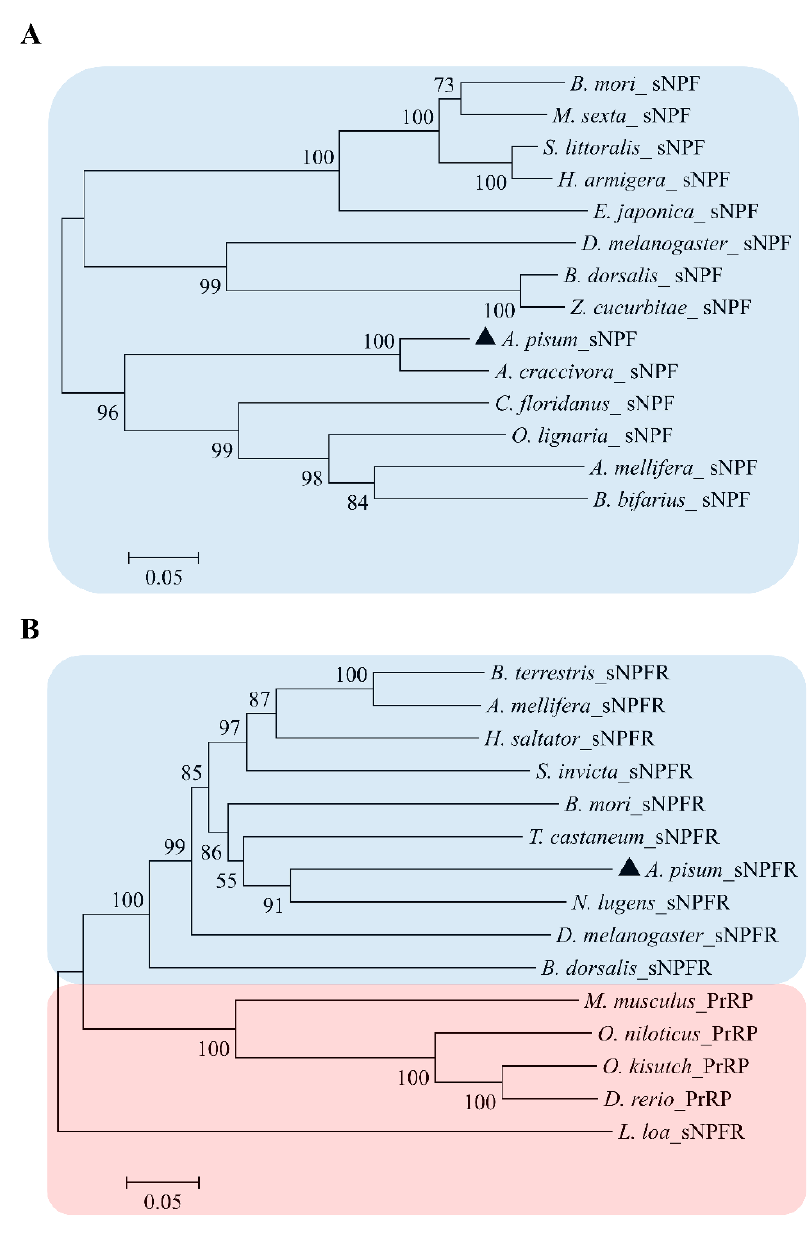
Figure 3. Phylogenetic relationship of sNPF precursors with other insect species ( A ) and sNPF receptors of invertebrates (blue box) with PrRP receptors of vertebrates (red box) ( B ). Loa loa sNPFR was selected as outgroup. The percent bootstrap support values are indicated by the number at branches. Table S3 contains the precursor and receptor accession number.